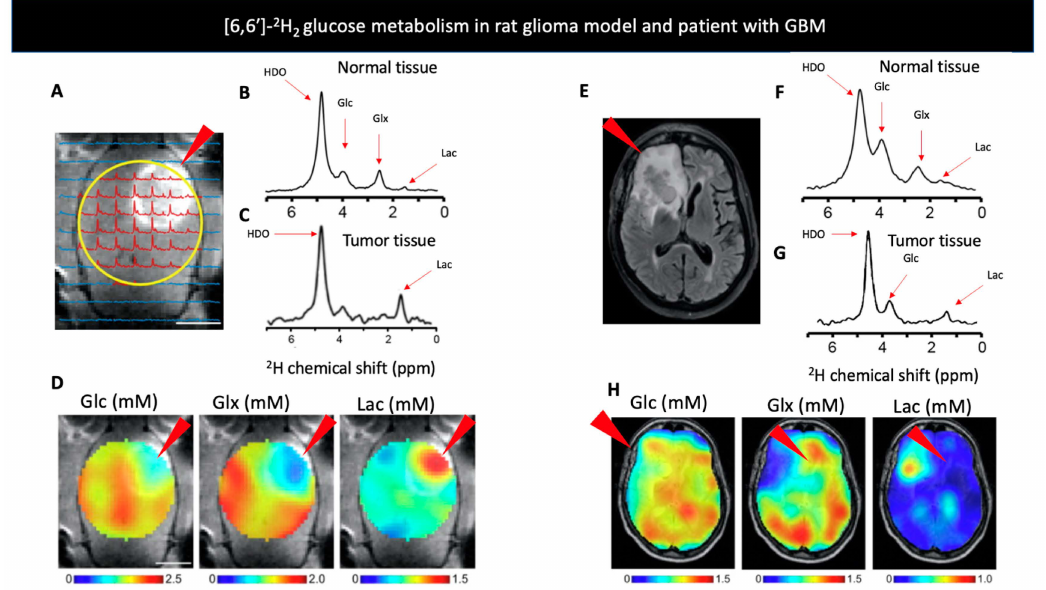
Figure 1. ( A ) Contrast-enhanced T 1 -weighted MRI image of a rat glioma model. The arrow indicates increased signal from the tumor region, with the 1 H image overlaid with the localized 2 H MR spectra. The yellow circle indicates the position of surface coil. ( B , C ) show deuterium NMR spectra acquired after infusion of [6,6 (cid:48) - 2 H 2 ] glucose (Glc) in a normal ( B , C ) tumor bearing rats’ brain. Red arrows indicate the chemical shifts of HDO, Glc, glutamate and glutamine (Glx), and [6,6 (cid:48) ]- 2 H 2 lactate (Lac). ( D ) Metabolic uptake maps from a rat glioma model produced after injection of Glc. Arrows indicate increased uptake of Glx and lactate around the tumor region. ( E ) T 2 -weighted fluid-attenuated inversion recovery MR image of a patient with glioblastoma multiforme (GBM), arrow indicates increased signal from tumor region. ( F , G ) show deuterium NMR spectra acquired after oral administration of Glc in a healthy volunteer ( F , G ) patient diagnosed with GBM, red arrows indicate the chemical shifts of HDO, Glc, Glx, and Lac. ( H ) Metabolic uptake maps from a patient diagnosed with GBM produced after oral administration of Glc. Arrows indicate increased uptake of Glx and lactate around the tumor region. Adapted from De Feyter et al. 2018 (non-commercial 4.0 international license, CC BY-NC